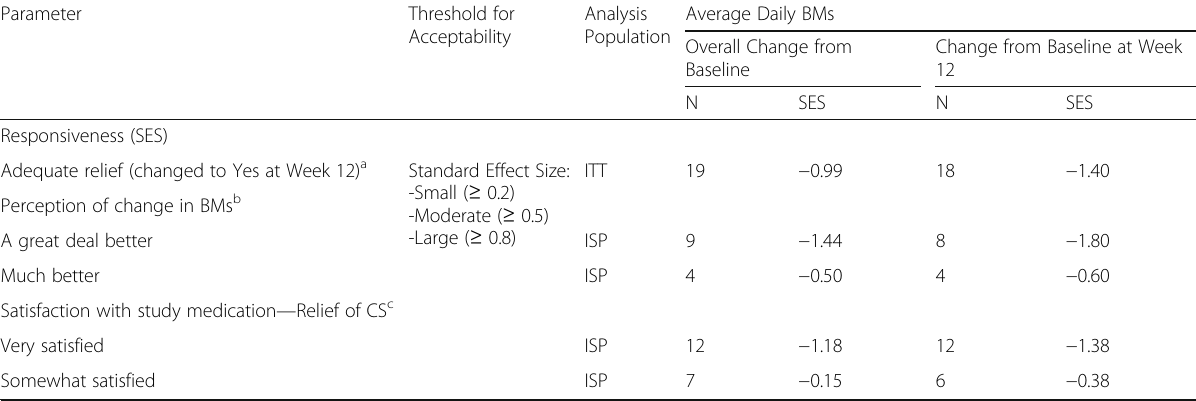
Table 2 Summary of Responsiveness